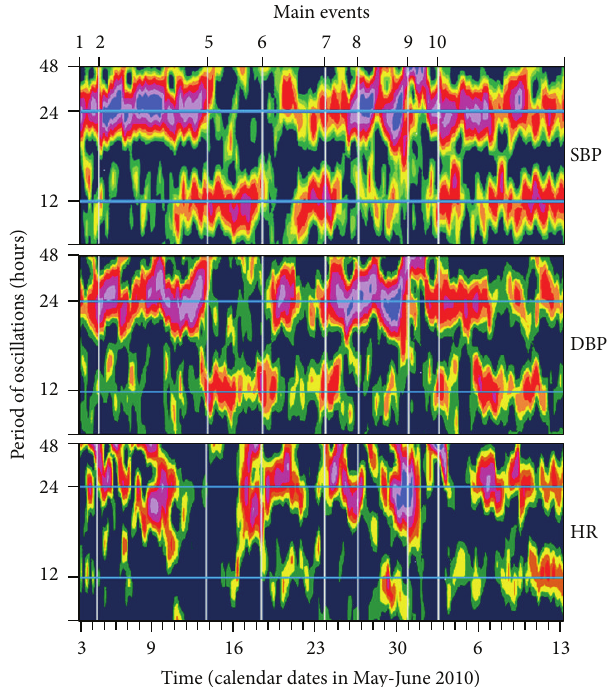
Figure 4: Gliding spectra of systolic and diastolic blood pressure and heart rate during treatment of heart failure and cardiac